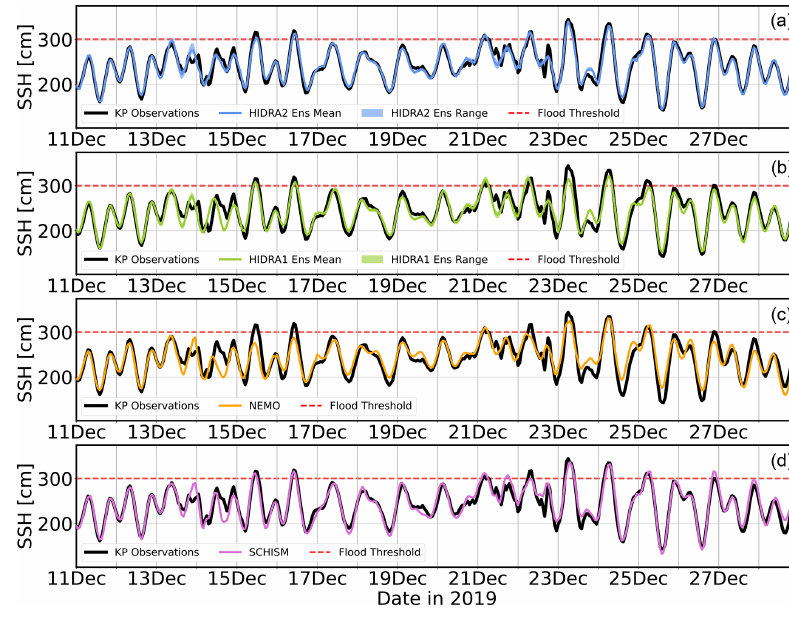
Figure 13. Same as Fig. 12 but for December 2019.